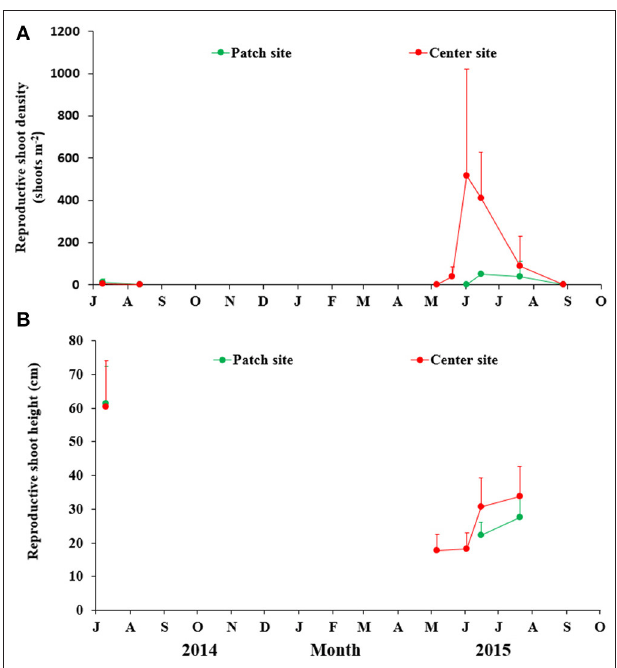
FIGURE 6 | Temporal changes in the reproductive shoot density (A) and height (B) of Zostera marina at the two study sites in Swan Lake. Values are means ± sd